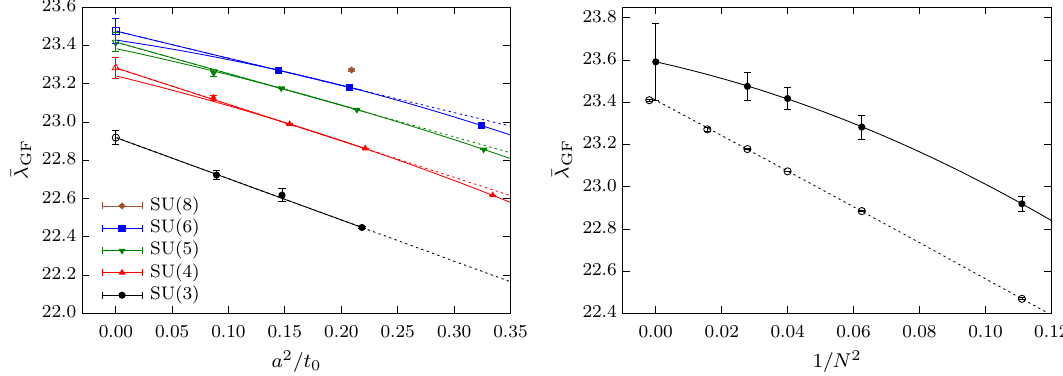
Fig. 4 Left:Continuumextrapolationof ¯ λ GF at t / t 0 = 0 . 4forallthedifferentgaugegroups.Right: Large N extrapolationsof ¯ λ GF inthecontinuum (solid line) and at finite lattice spacing (dotted line). The points at finite lattice spacing have been slightly shifted for better